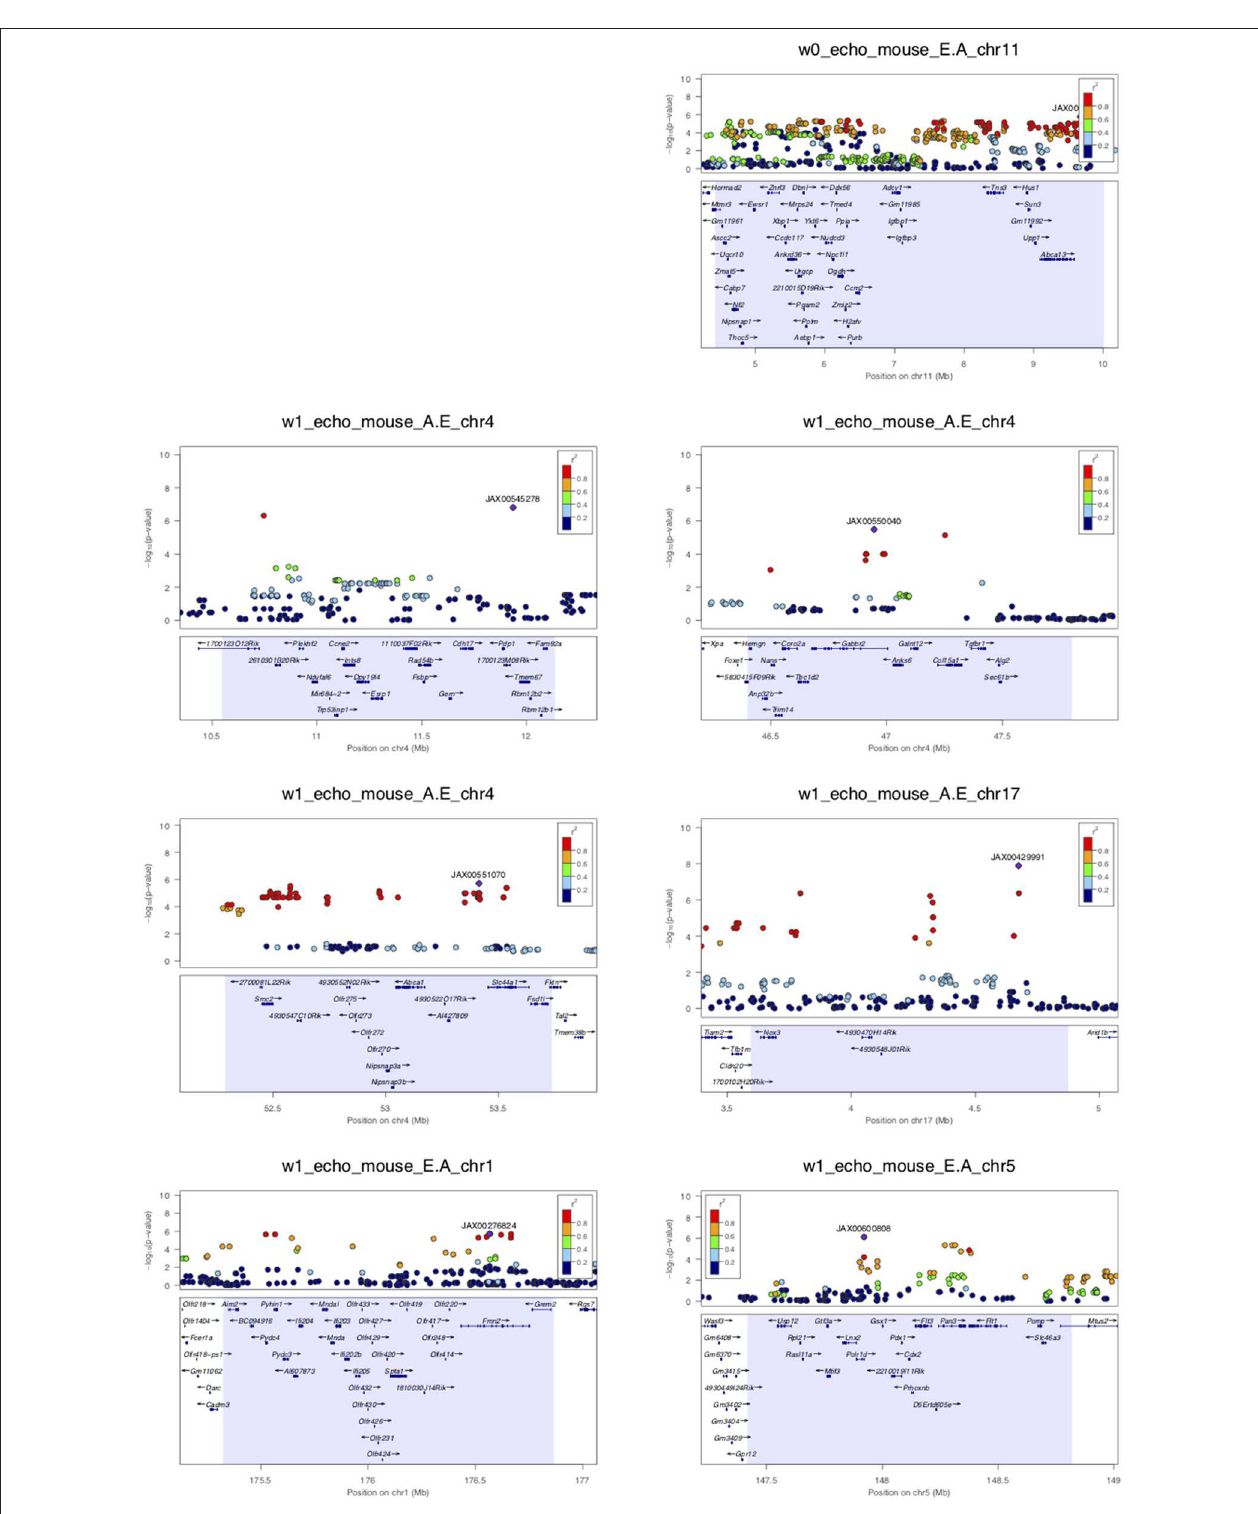
FIGURE 2 | LocusZoom plots for regional visualization of genome-wide association scan results of echocardiographic diastolic function loci. The regional lead single nucleotide polymorphism (SNP) is represented by the purple diamond symbol and annotated by its SNP ID. Surrounding SNPs are color coded according to the strength of pairwise linkage disequilibrium (LD) in terms of the r 2 metric to the lead SNP. w0, w1, w2, and w3 denote baseline, week 1, week 2, and week 3 of isoproterenol. E.A denotes E/A ratio. A.E denotes A/E ratio.